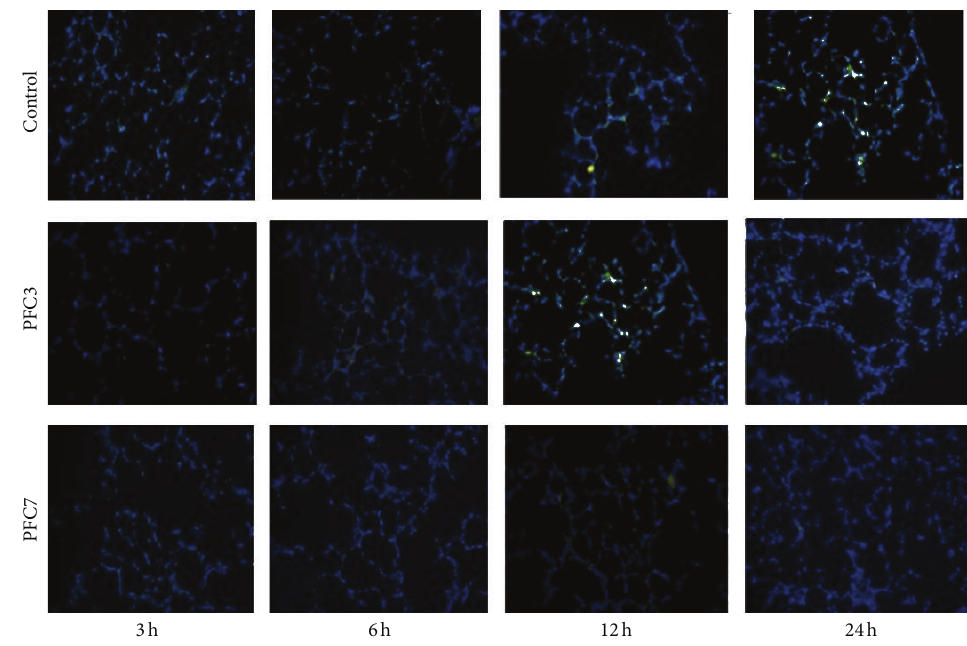
Figure 2: TUNEL staining after the different periods of cold ischemia. DAPI and FITC staining: DAPI-positive cells (nucleated cells) are blue and FITC-positive cells (TUNEL-positive) are green. There is predominance of TUNEL-positive cells in PFC 3 group at 12h of cold